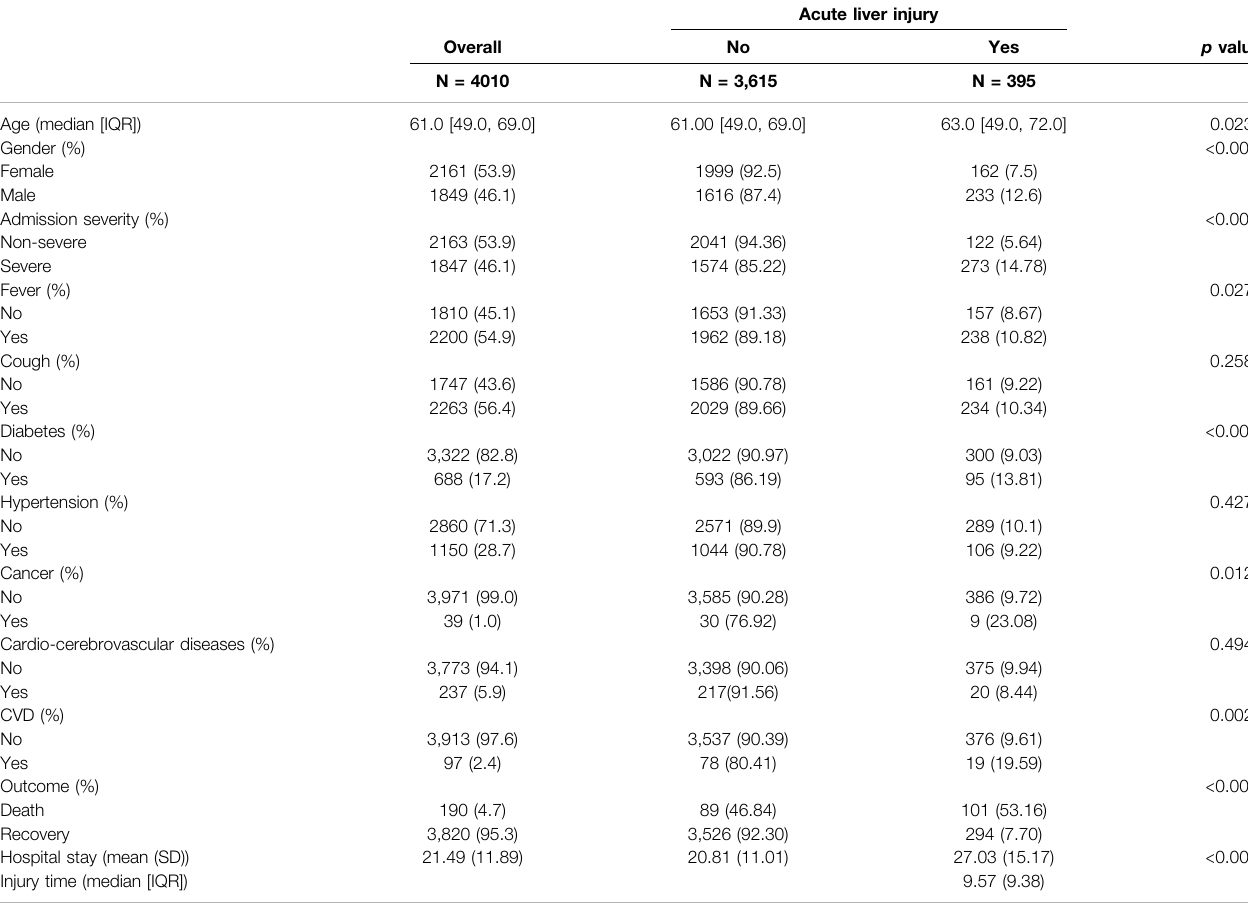
TABLE 1 | Characteristics of 4010 patients with COVID-19 at